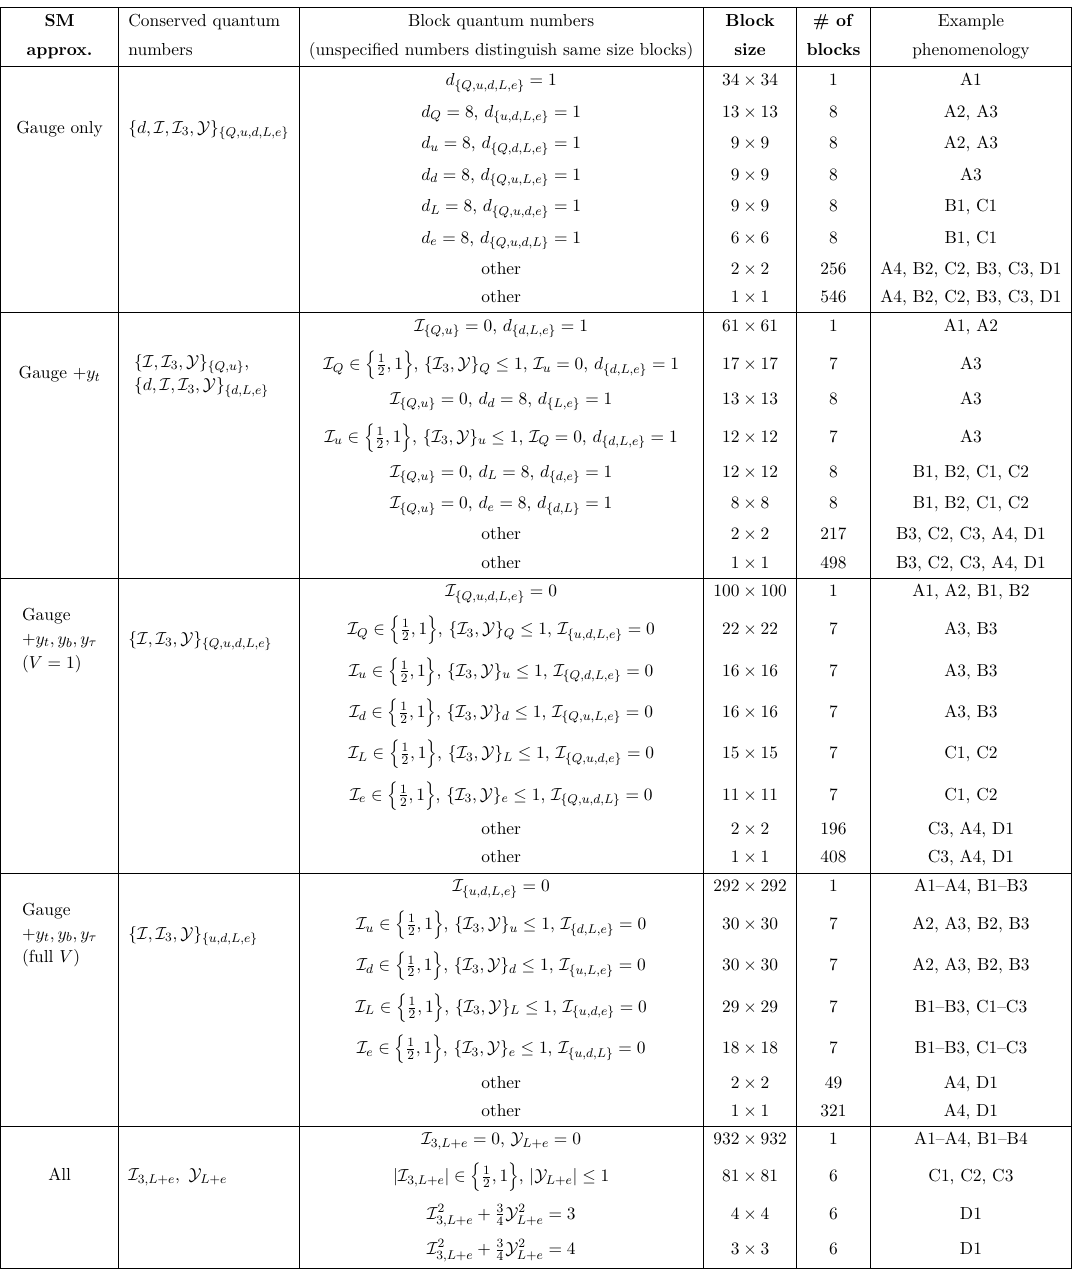
Table 9 . The flavour quantum numbers of the blocks of the anomalous dimension matrix under different approximations of the SM interactions. The I , I quantum numbers are given in the 3 , Y basis where the Y and Y Yukawa matrices are diagonal. We recall that a block multiplicity of 7 u e implies there is one block with the charges of each component of an octet apart from the isospin singlet